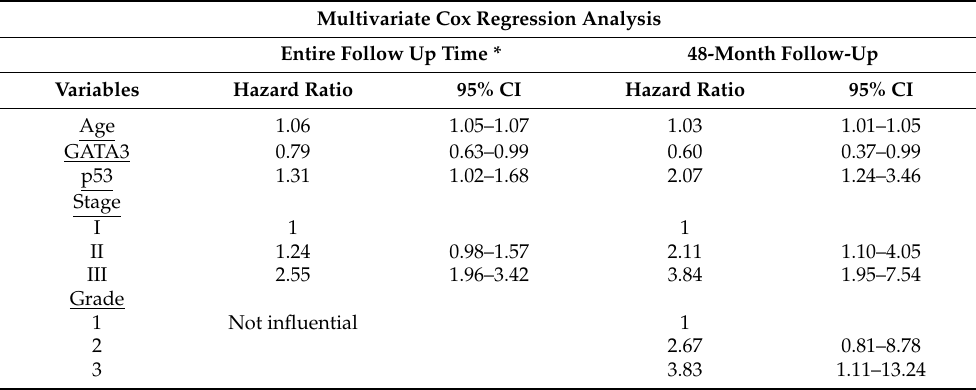
Table 3. Multivariate Cox proportional hazards model for the overall survival. Multivariate Cox Regression Analysis Entire Follow Up Time * 48-Month